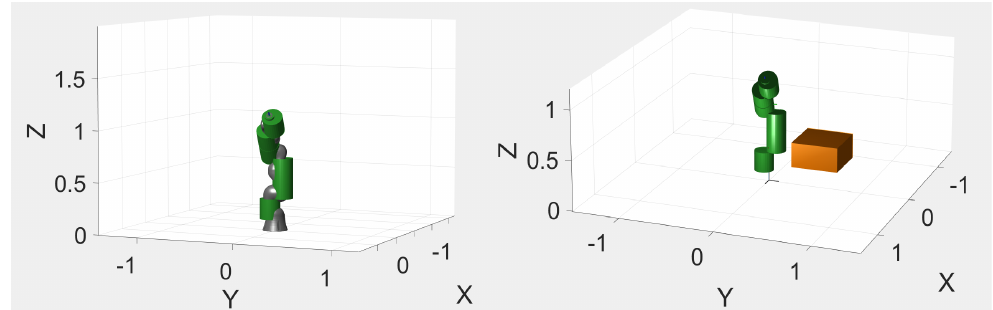
Figure 9. ( Left ) Mesh primitives (green colored) representing bounding volumes of collision envelope overlapped to the robot model. ( Right ) Collision envelope meshes attached to the robot structure using DH convention and collision box. The axes measurement units are assumed in